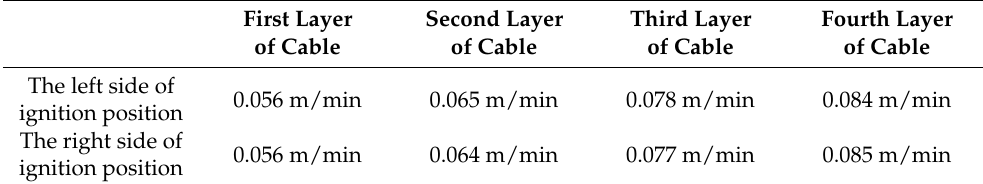
Table 4. The fire spread rate on both sides of the